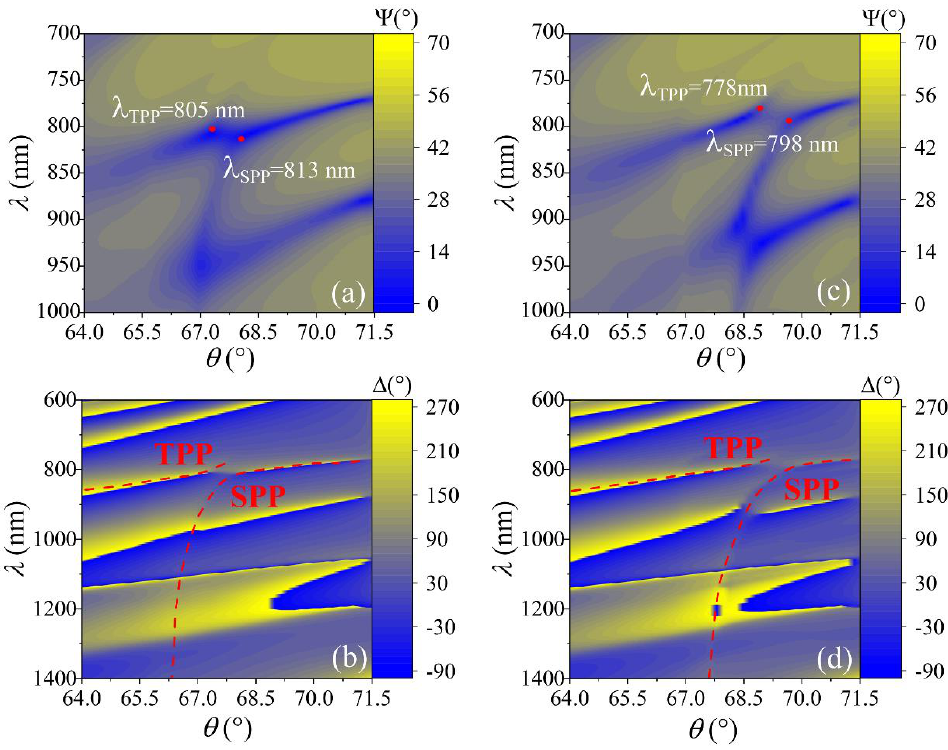
Figure 3. The dispersion maps λ (θ) of ellipsometric parameters Ψ(°) ( a ,c) and Δ(°) ( b , d ) for structure PC (TiO 2 /SiO 2 (110 nm/200 nm)/with gold nano-bumps (50 nm) in water (left side) and in ethanol (right side). The red points show the strong coupling effect between the Tamm plasmons and the surface plasmon at zero detuning.